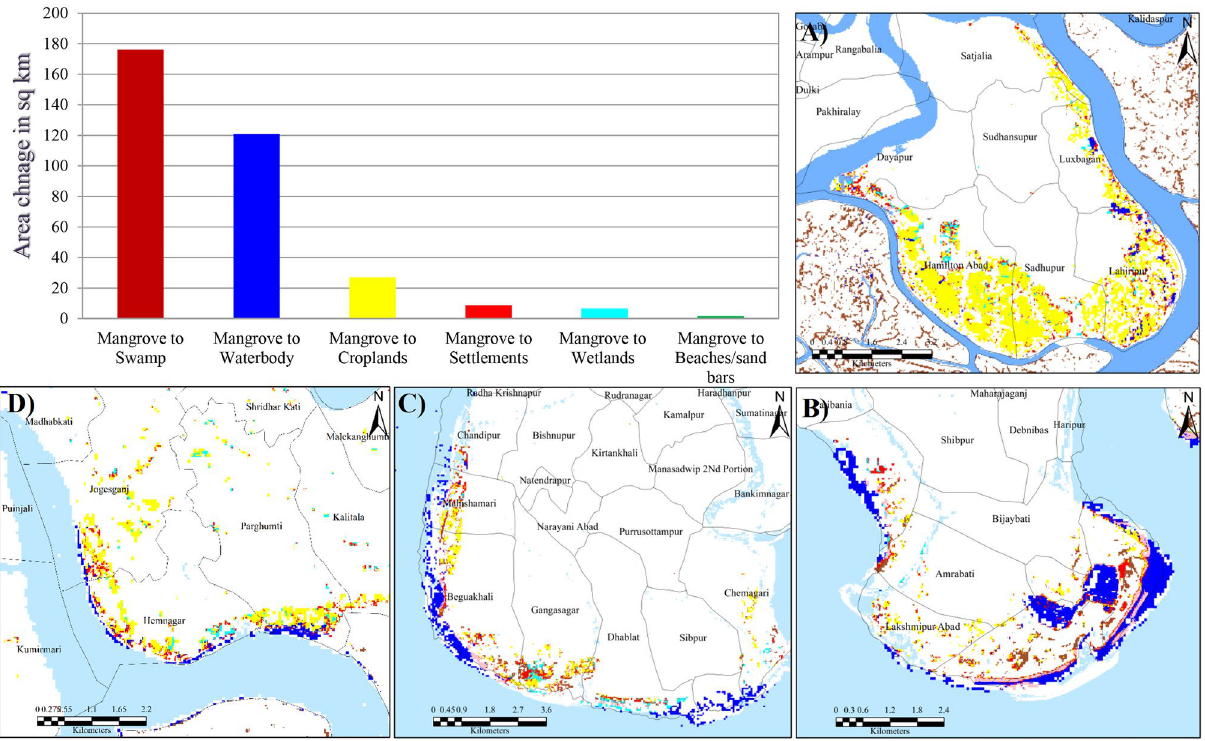
Figure 5. Change of mangrove cover under different land use/land cover classes Four important degraded mangrove hotspots in SBR; ( A ) Dayapur and Annpur village of Gosaba block mainly due the agricultural encroachment, ( B ) major built-up expansion Bakkhali area due the tourism development and coastal erosion at, ( C ) beaches and sand bar expansion at southern part of Sagar Island, ( D ) waterlogging wetlands and agricultural encroachment at Southern part of Hingalganj.). (The Landsat satellite images are obtained from the EarthExplorer [https:// earth explo rer. usgs. gov/]. The maps were prepared using ERDAS IMAGINE 2014 [https:// hexag on. com/ produ cts/ erdas- imagi ne] and ArcGIS 10.8.2 software [https:// deskt op. arcgis.